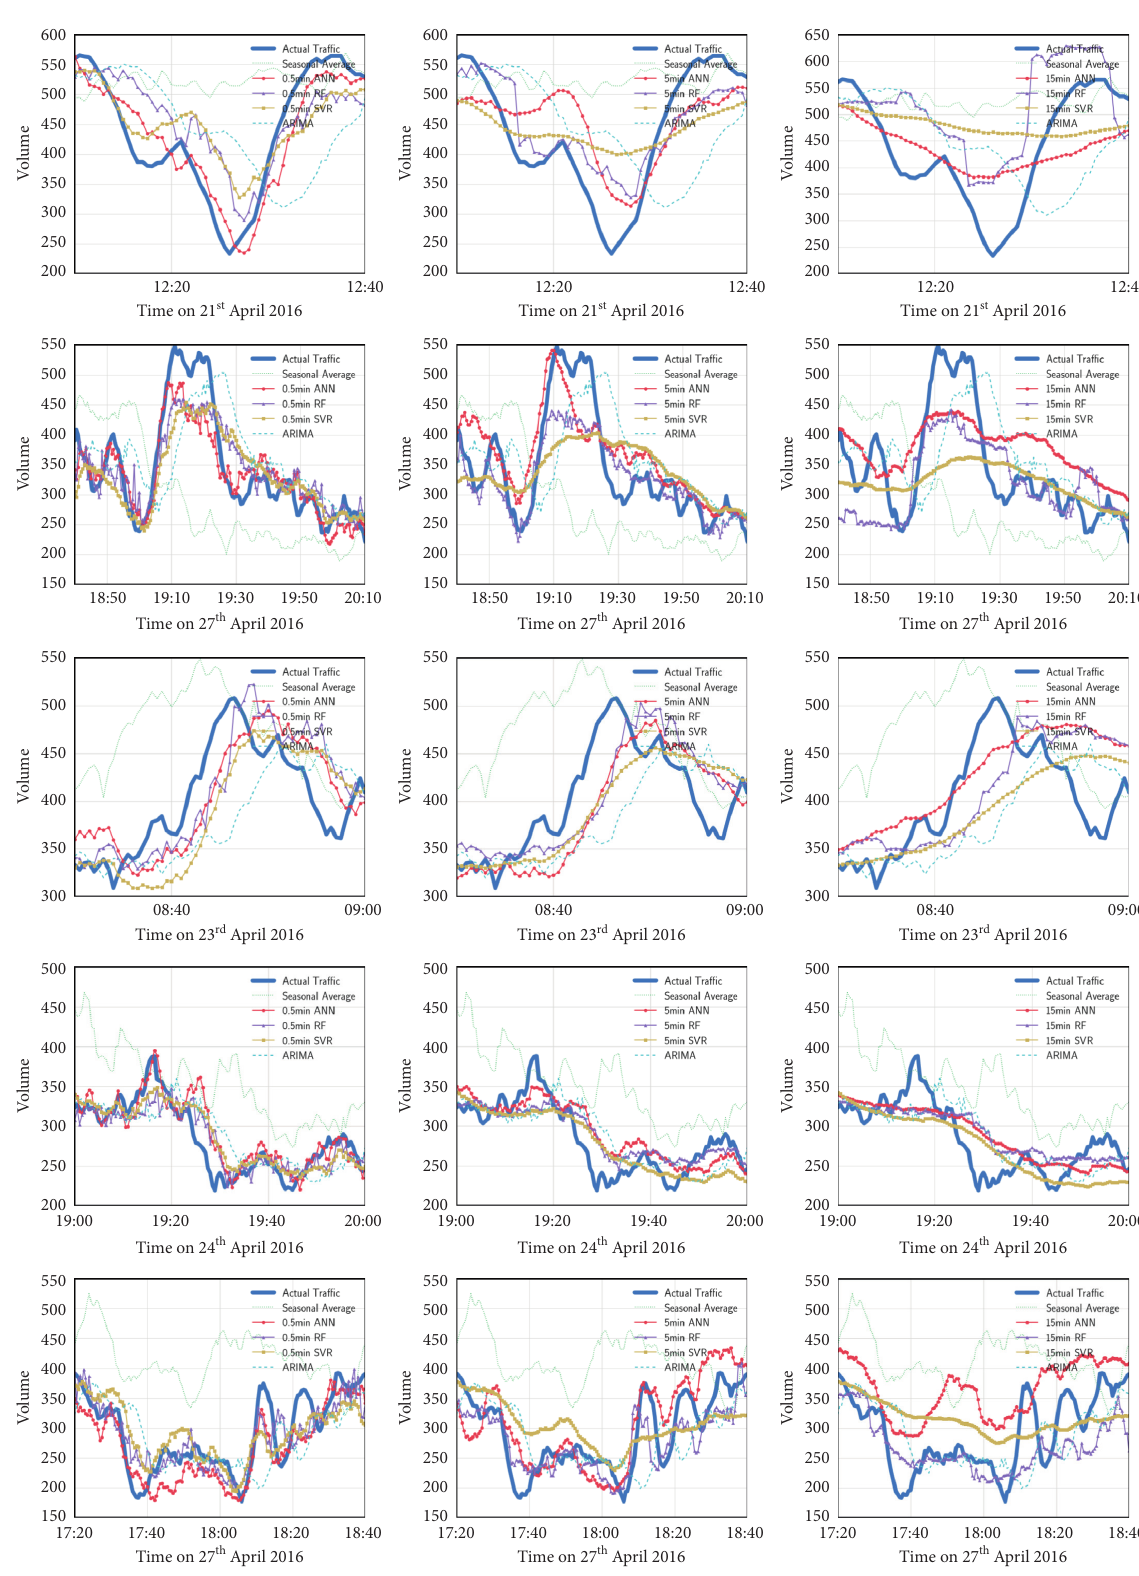
Figure 6: Additional examples of nonrecurring congestion events. Predictive models based on machine learning methods provide good tracking performance, especially at the high-resolution (30sec) input data aggregation